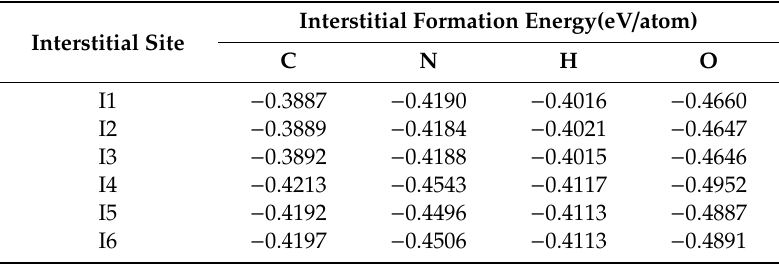
Table 2. Octahedral interstitial atom formation energy at 0 shearing